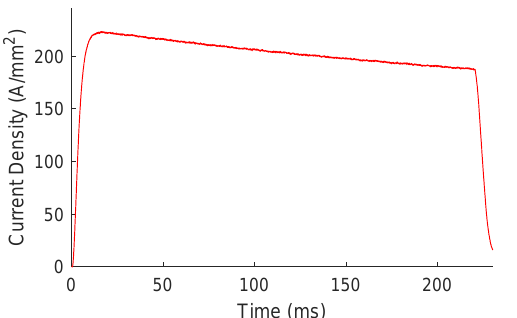
Figure 23. DC pulse of approximately 200 A/mm 2 using the Ametek power supply with voltage control; Air-cooled test